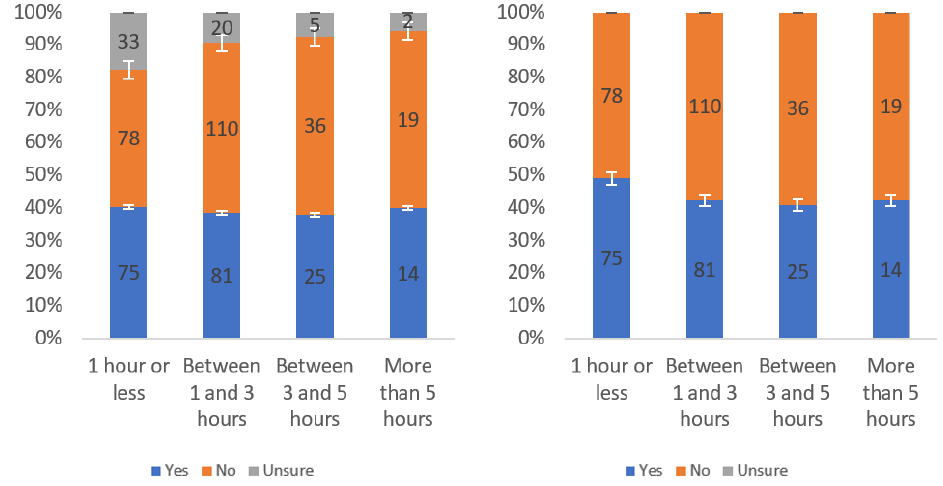
Figure 60. Responses regarding label annoyingness by internet usage level including ( left ) and ex- cluding ( right ) unsure responses. excluding ( right ) unsure